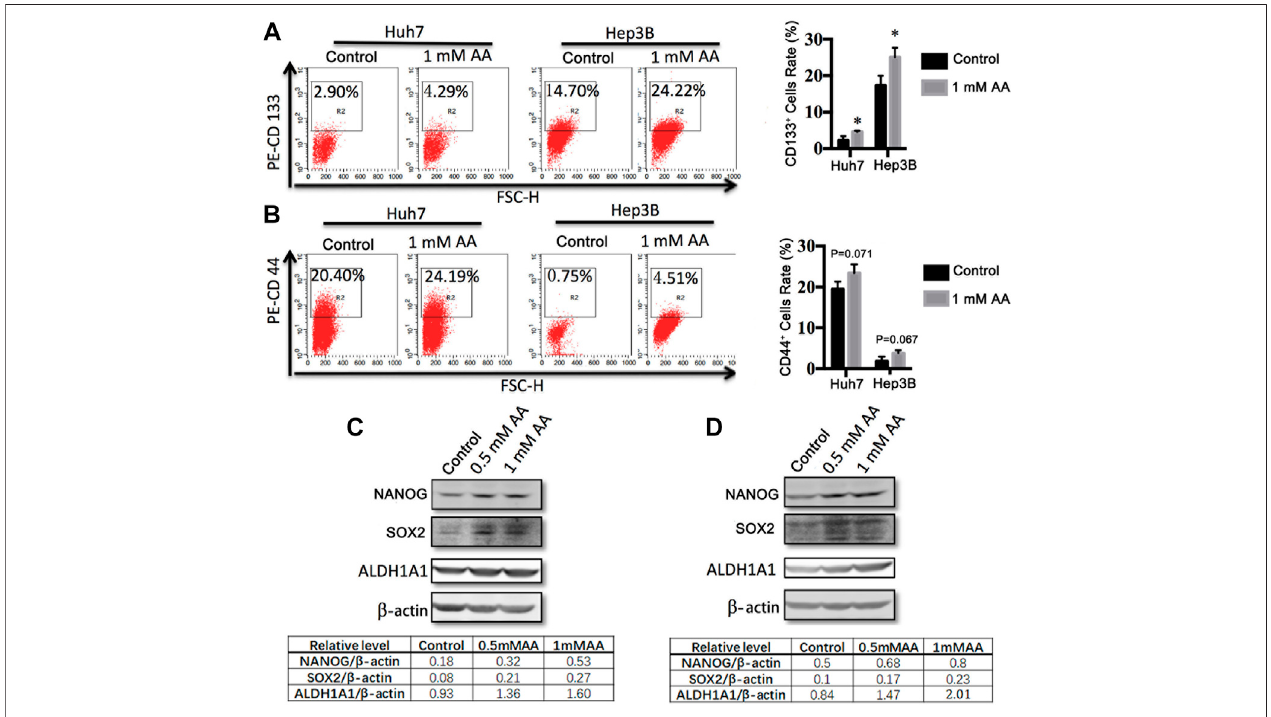
FIGURE5| AAregulatestheexpression ofstemness genesinlivercancercells. (A,B) Flowcytometricanalysisoftheexpressions ofCD133andCD44inHuh7 (A) and Hep3B (B) stem cells treated with different concentrations of AA. (C , D) The protein levels of stemness genes in Huh7 (C) and Hep3B (D) stem cells treated with different concentrations of